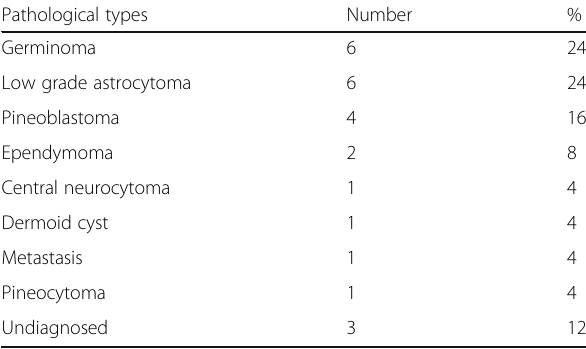
Table 2 Pathological types of the cases Pathological types